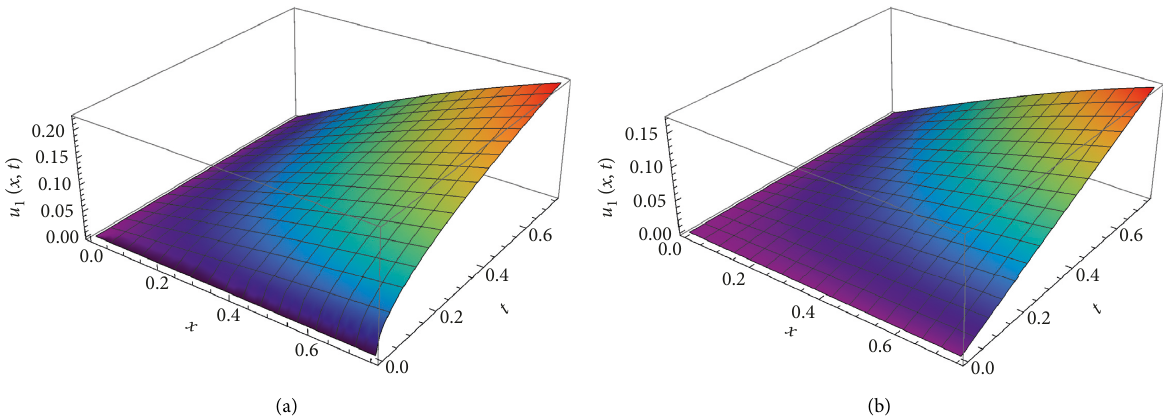
Figure 4: The graphical comparison of the iterative solutions for (25) through various values of t at x � 0 . 75 and α � 0 . 5 , 1, respectively. (a) The graphical comparison of the iterative solutions for (25) through various values of t at x � 0 . 75 and α � 0 . 5. (b) The graphical comparison of the iterative solutions for (25) through various values of t at x � 0 . 75 and α � 1.